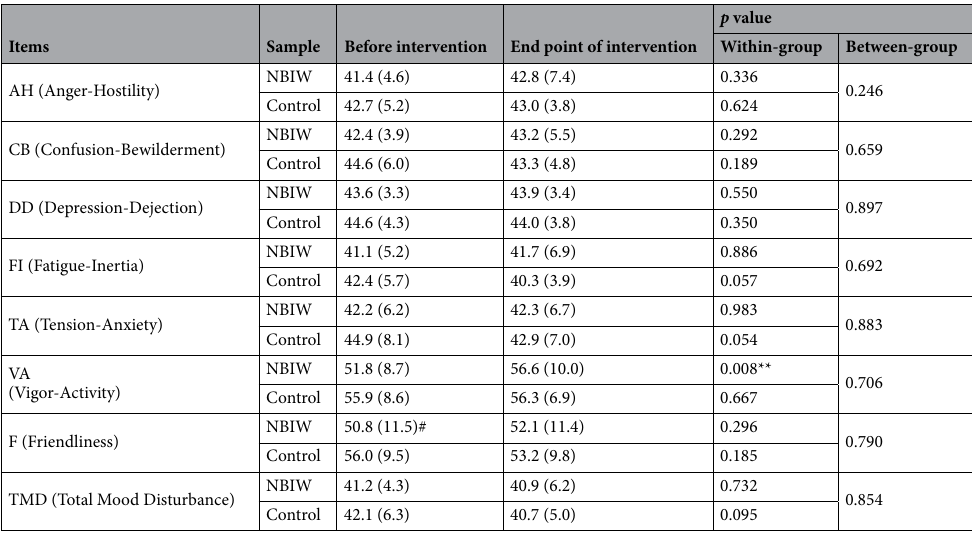
Table 6. Profile of mood states 2nd edition-adult short (POMS2-A short) scores. NBIW neutral bicarbonate ionized water. Control: n = 27, NBIW: n = 25. Values are shown as mean ( SD ). Within-group comparison: A significant difference was found compared to before intervention (** p < 0.01: Wilcoxon signed rank test). Between-group comparison: Before intervention, in “Friendliness” a significant difference was found compared with the control group (# p < 0.05); At the end point of intervention, no significant between group (Wilcoxon rank sum test).